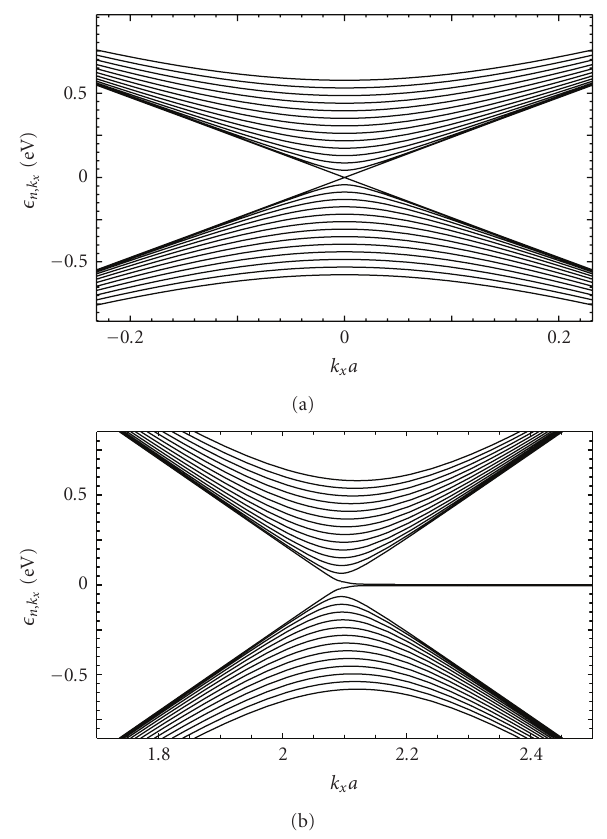
Figure 1: Electron band structures for perfect (a) 173-AGNR and (b) 100-ZGNR. The lattice constant along the nanoribbons is a = 2 . 46 ˚ A .